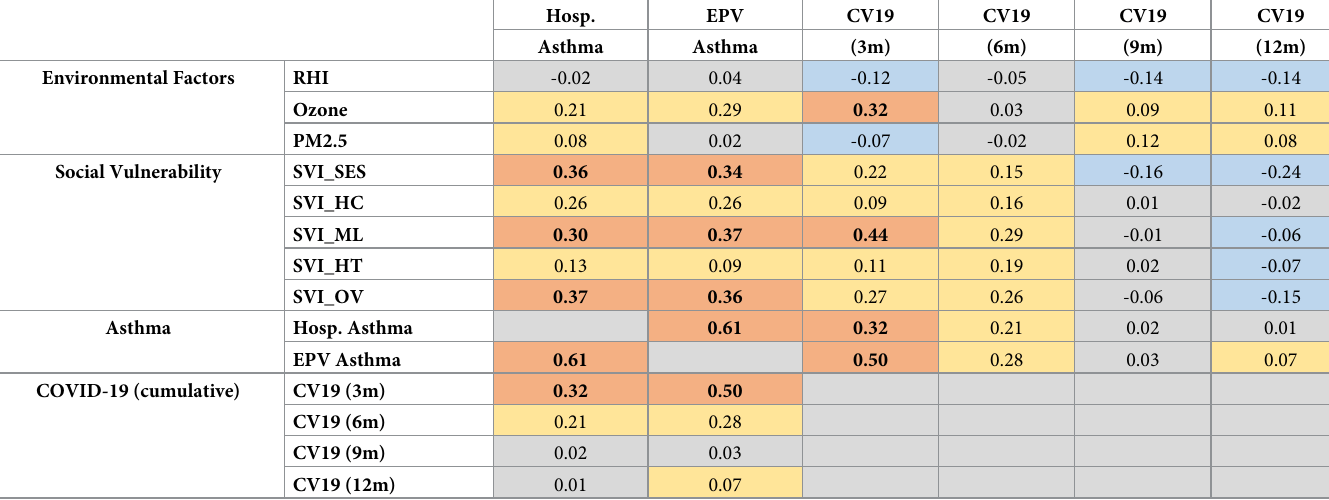
Table 2. Spearman’s rho (correlation coefficient) for social and environmental vulnerability, asthma, and COVID-19. With regards to COVID-19, strongest correla- tion was observed between the cumulative incidence during the first quarter of the pandemic in LA (Mar-Jun 2020) and the estimated prevalence of asthma, SVI due to minority status and language barriers, asthma hospitalization crude rate, and the percentile score for ozone levels. With regards to asthma, SVI due to socioeconomic sta- tus, minority status and language barriers, and overall SVI were also significantly correlated with both asthma hospitalization rate as well as the estimated prevalence. Hosp. EPV